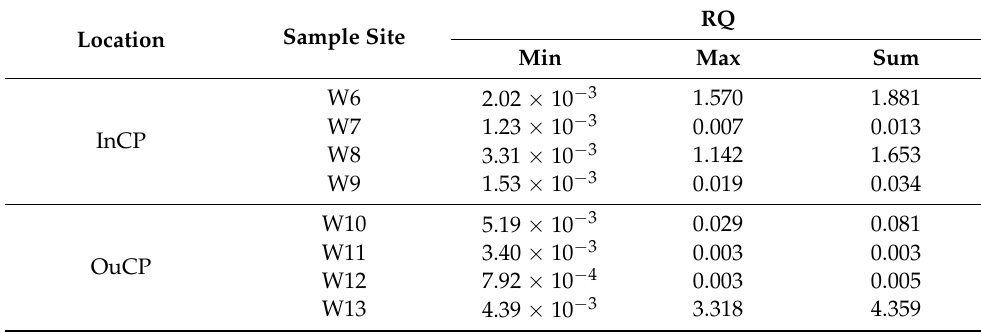
Table 2. RQs of water in the rivers from study